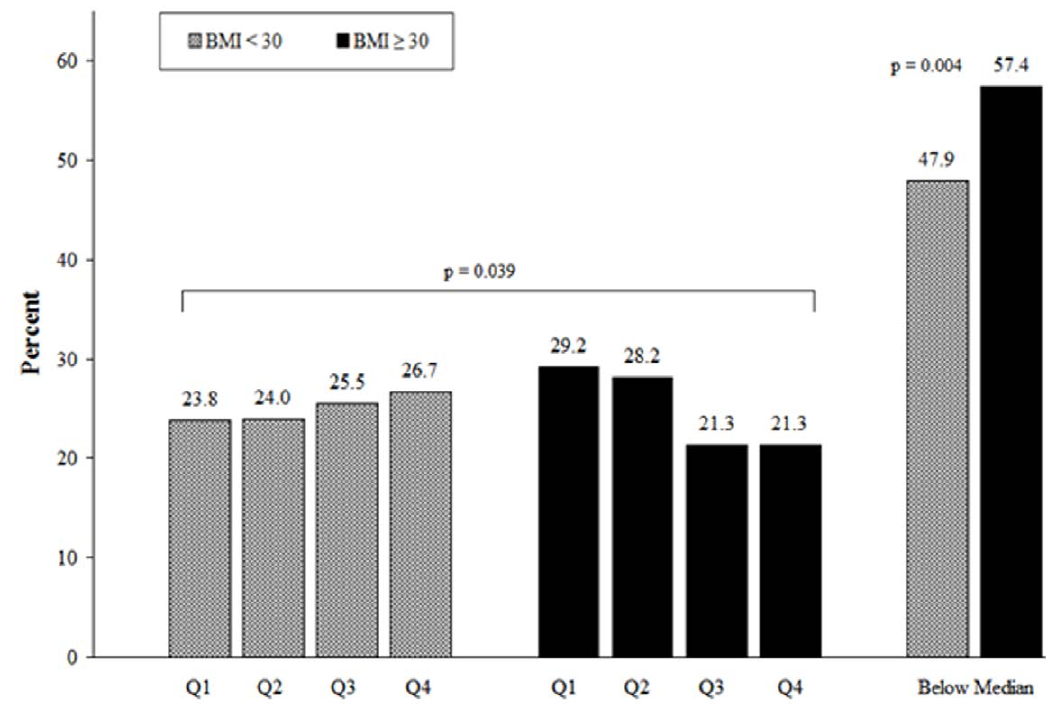
Figure 1. Distribution of PFP quartiles by obesity.